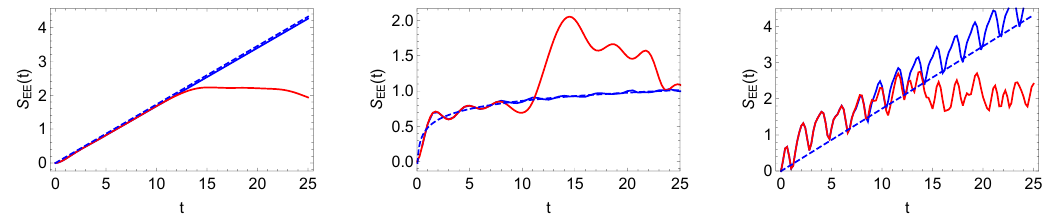
Figure 6: The growth of entanglement entropy for the fully-filled initial state and various values of the defect hopping constant, (cid:34) = 1 / 3 (left), (cid:34) = 1 (center) and (cid:34) = 3 (right). Solid blue curves stand for the exact expression (28), while the dashed blue curves stand for the asymptotics (29) (left and right panels) or (30) (middle panel). The red lines show evolution in the finite size system with N = 5